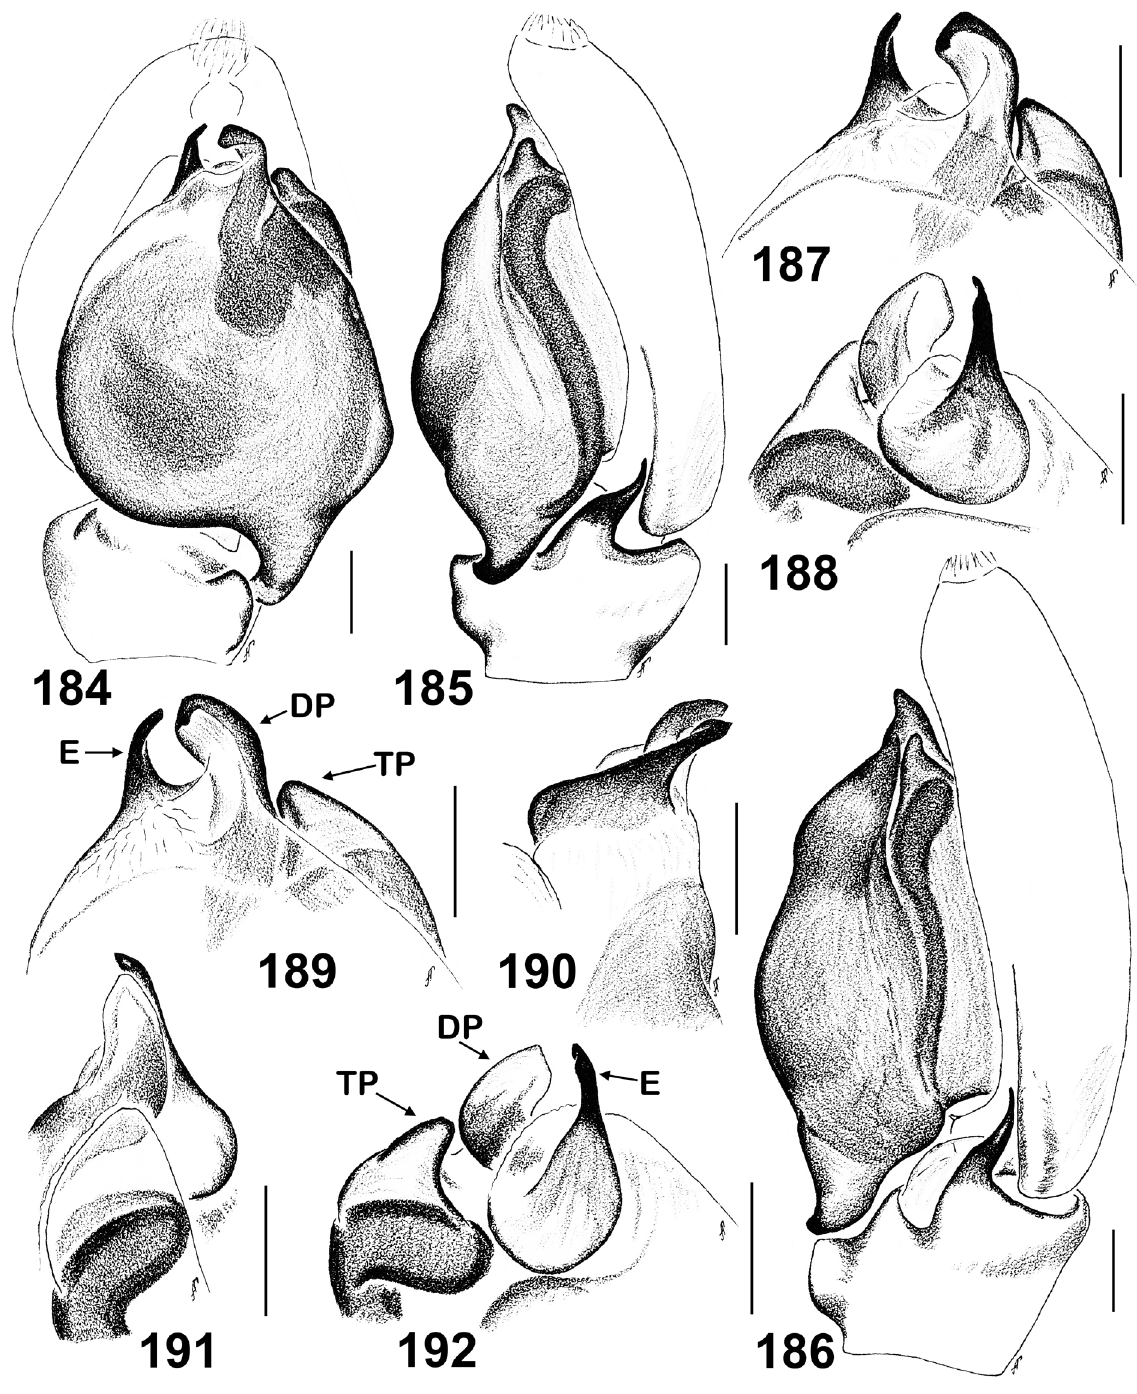
Figs 184–192. Male palp of Stenaelurillus guttiger (Simon, 1901). 184 . Male palp, ventral view. 185– 186 . Male palp, retrolateral view. 187–192 . Embolic division. 187 , 189 . Ventral view. 188 , 192 . Dorsal view. 190 . Median view. 191 . Retrolateral view. Specimens: 186, 189–192 = paratype of S . natalensis Haddad & Wesołowska, 2006 from South Africa ( Ndumo GR; NCA 2006/678); 184–185, 187–188 from South Africa (Polokwane GR, NCA 2008/2067). Abbreviations: see Material and methods. Scale bars: 0.1